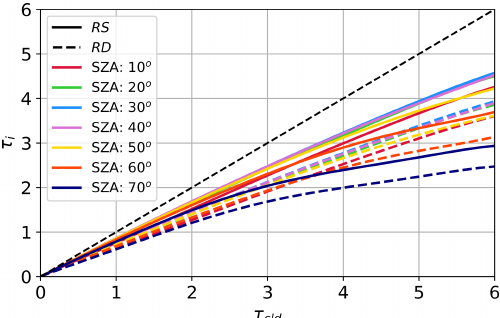
Figure A1. Simulations of diffuse radiance transmittance at 500nm, Tl dif = L dif /F 0 when scanning across the sensor FOV in the az- imuthal direction. Line color corresponds to τ cld value. The sun is positioned at a viewing angle of 0 ◦ , and the SZA is 20 ◦ .